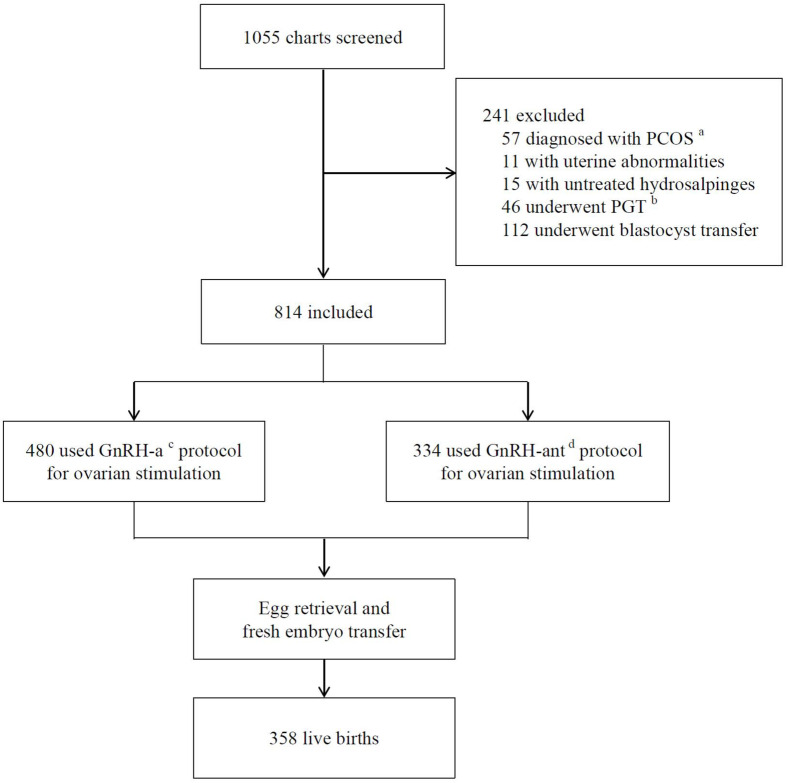
Flow chart of study design. aPCOS-polycystic ovary syndrome. bPGT-preimplantation genetic testing. cGnRH-a-GnRH-agonist long protocol. dGnRH-ant-GnRH antagonist protocol.